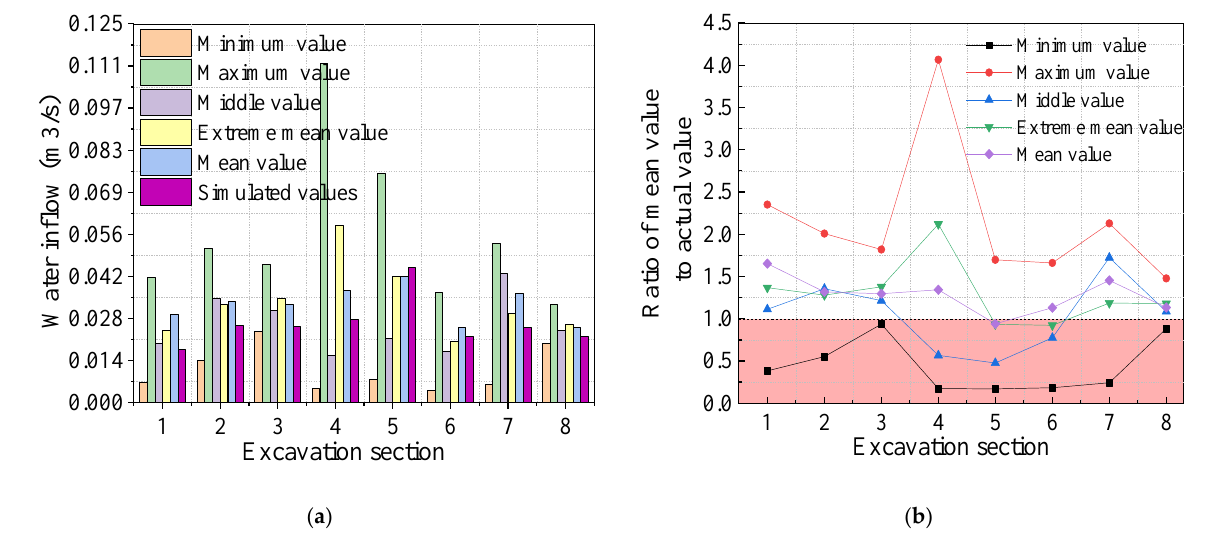
Figure 19. Comparison of simulated and measured values for the main shaft of Shaft No. 1 without grouting excavation. ( a ) Comparison of theoretical and measured water inflow under different permeability coefficients, ( b ) Ratio of different theoretical water surges to measured values. Where 1 stand for S1ZK0+198.7 to +278.7, 2 stand for S1ZK0+263.5 to +315.5, 3 stand for S1ZK0+263.5 to +323.5,4 stand for S1ZK0+263.5 to +333.5, 5 stand for S1ZK0+295.9 to +375.9, 6 stand for S1ZK0+364.3 to +444.3, 7 stand for S1ZK0+497.5 to +597.5, 8 stand for S1ZK0+730.9 to +778.484.